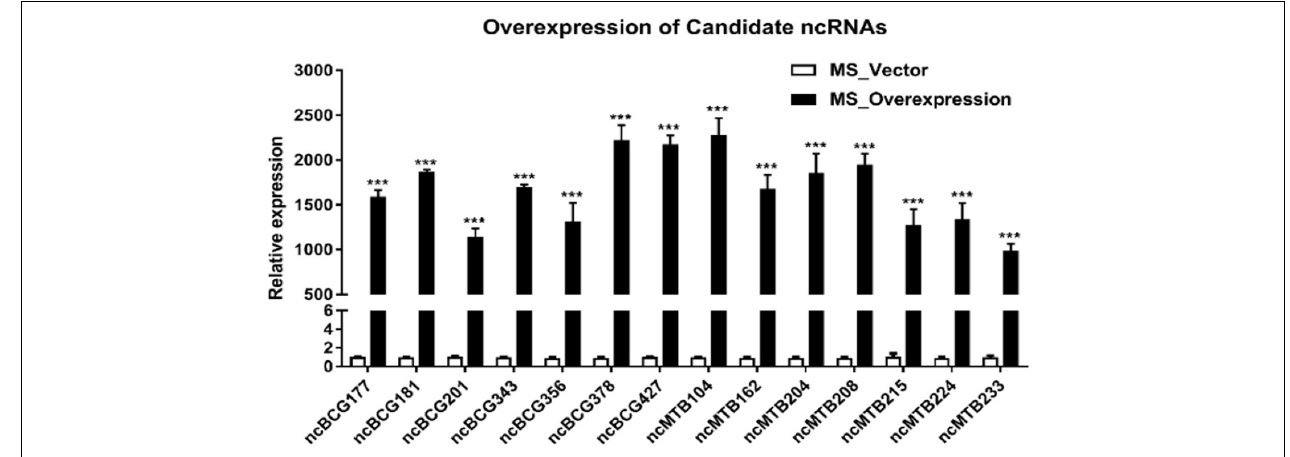
FIGURE 8 | Expression of candidate sRNAs in each overexpressing MS strain. Data are the mean ± SD of three replicate samples. *** p < 0.001 ( t -test).